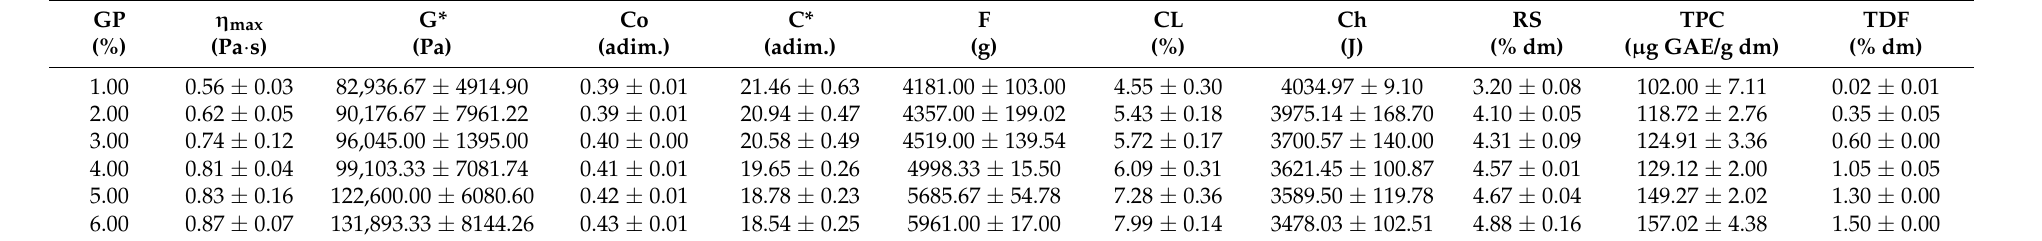
Table 4. The effects of GP on the responses used in the experimental